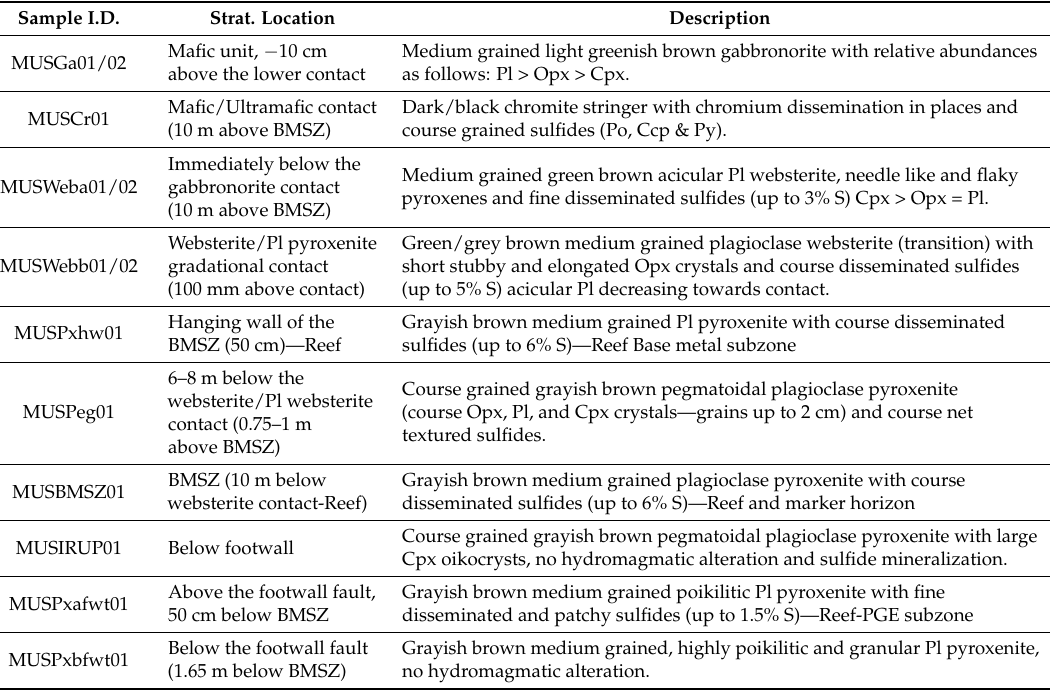
Table 1. Samples from Unki Mine MSZ and adjacent rocks